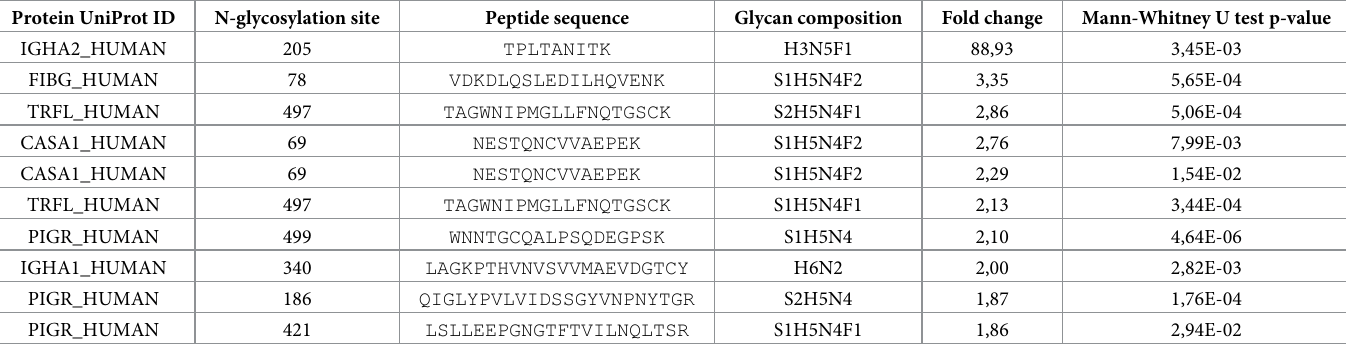
Table 2. The top 10 significant (p < 0.05) glycopeptides according to fold change when samples were compared between Rochester mothers and OOM mothers. Nine out of 10 glycopeptides were also significant as analyzed by the Benjamini-Hochberg method. Further details can be found in S2 Table. Protein UniProt ID N-glycosylation site Peptide sequence Glycan composition Fold